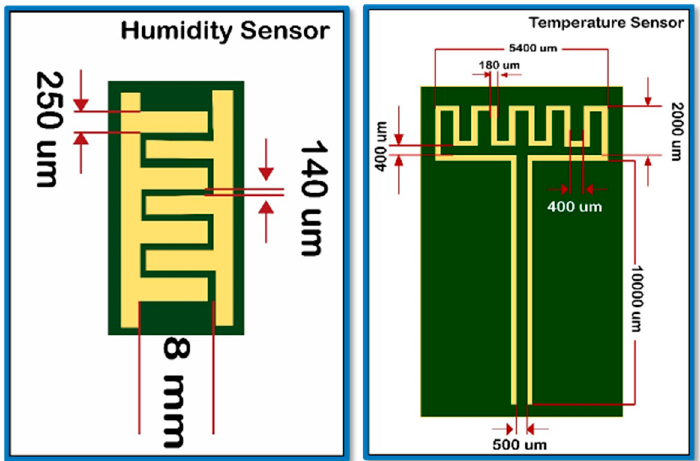
Figure 1. Design and dimensions of sensor electrodes for humidity sensor (left) and temperature sensor (right).